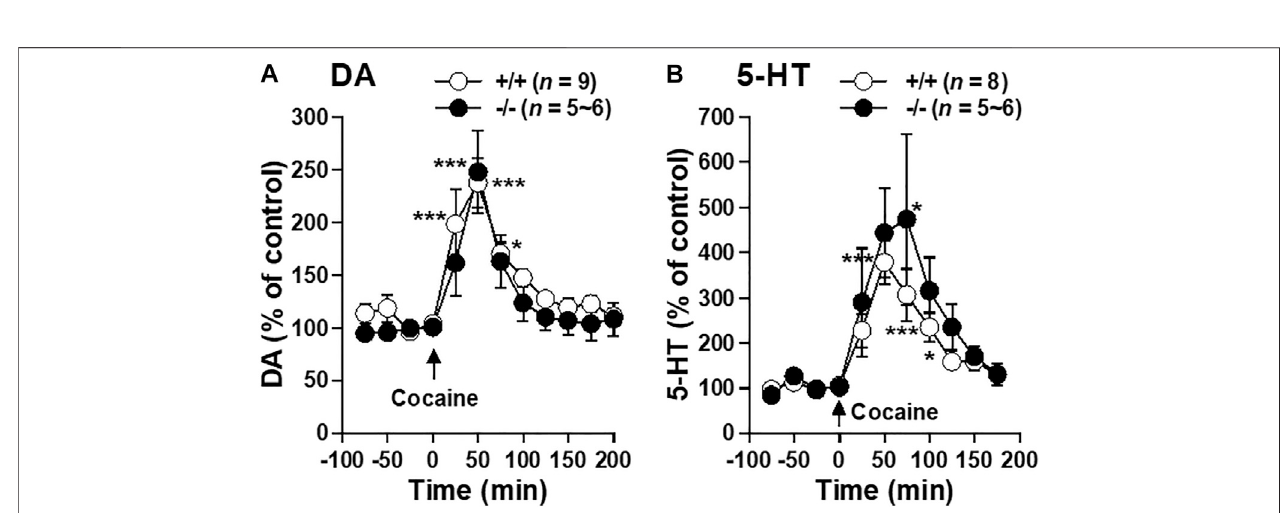
Frontiers in Pharmacology |